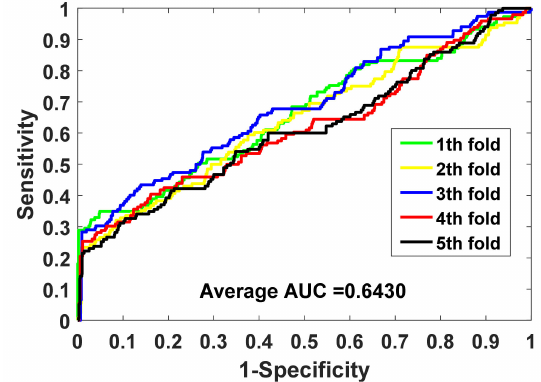
Figure 2. The ROC generated by SIPGCN in the human data set.